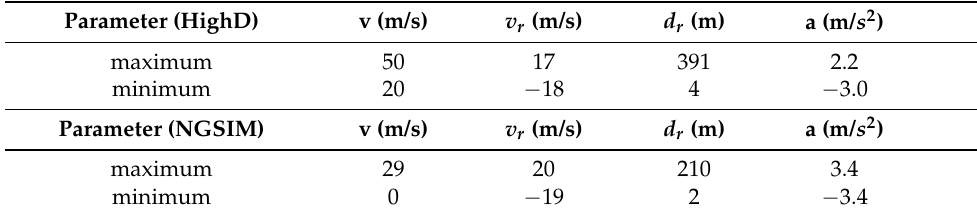
Figure 5. An illustration to show the distribution and density of parameters in the car-following case based on the HighD and NGSIM. Table 2. Value range of parameters in car-following